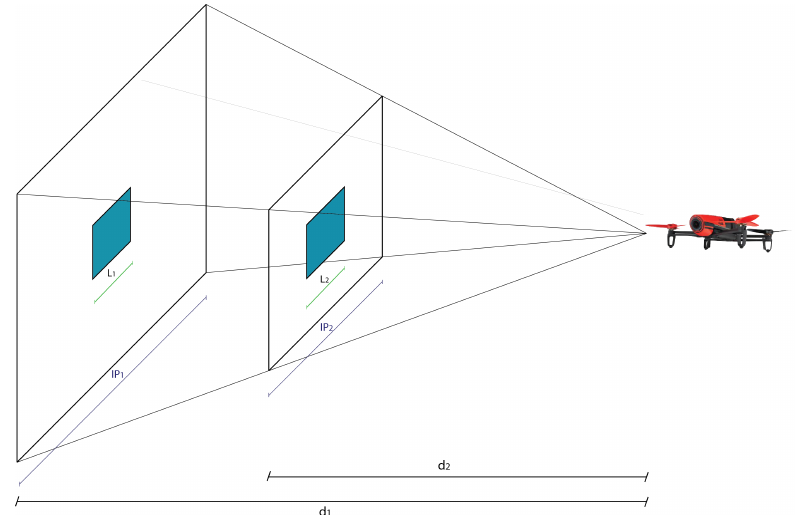
Figure 11. Relation between the area and distance.